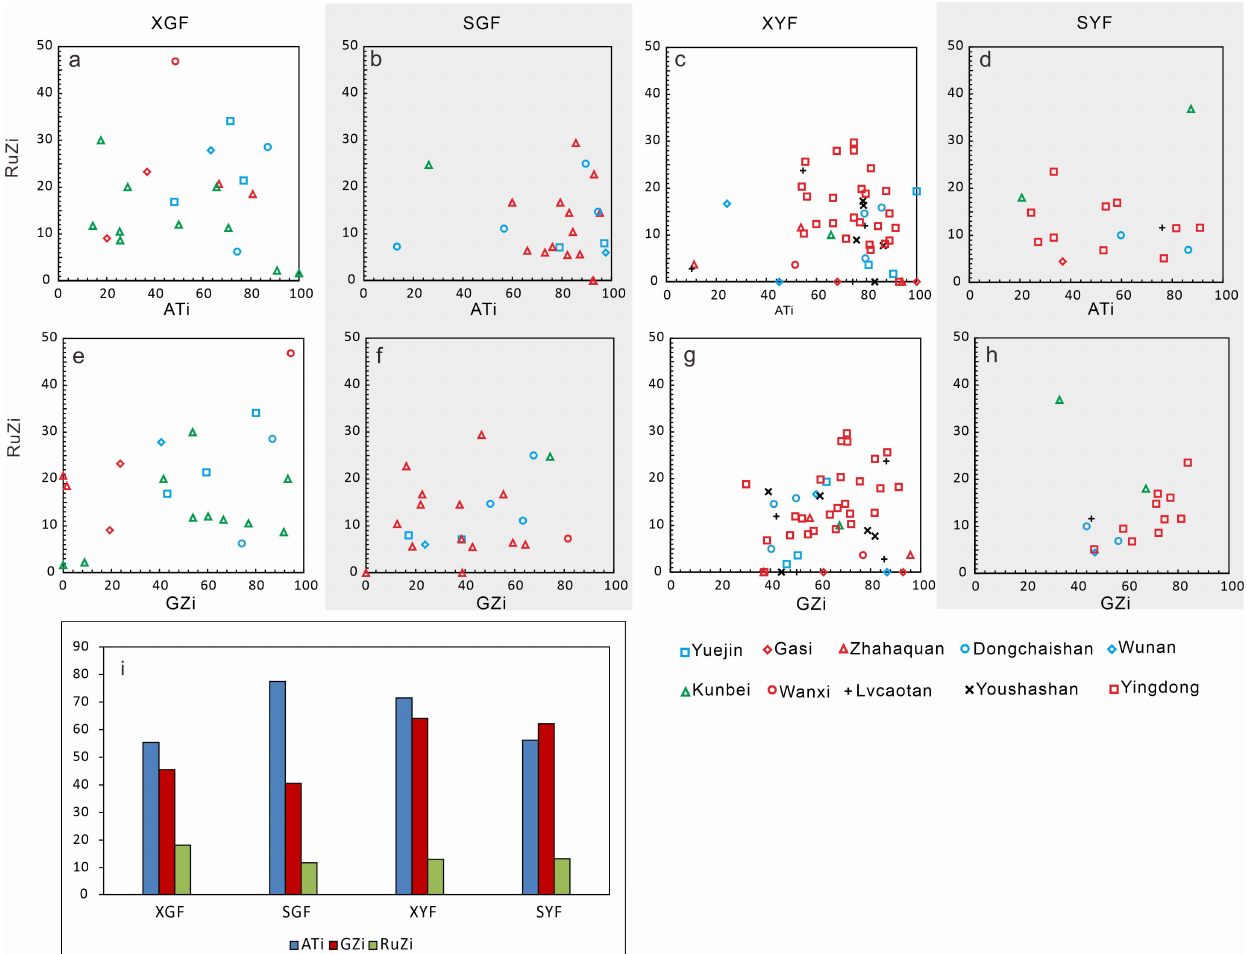
Figure 7. Heavy mineral ratios (ATi, GZi, and RuZi) of each location for each formation. ( a – d ) Binary plot of heavy mineral ratios (ATi and RuZi) for each formation. ( e – h ) Binary plot of heavy mineral ratios (GZi and RuZi) for each formation. ( i ) The average values of the ATi, GZi, and RuZi index in each